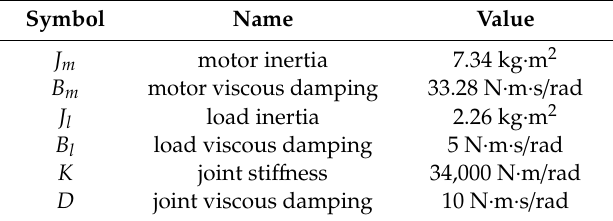
Table 1. Identified modular drive joint parameters.